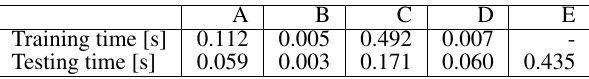
Table 1. Comparison of the computation times for the artificial dataset. A: MLM (cosine, variance, training set size 2500, R size 250), B: One-Class-SVM, C:Isolation forest, D: Global RX,